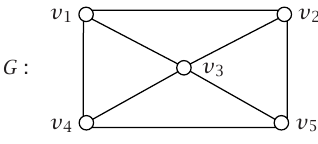
Figure 1.1 . Illustrating resolving